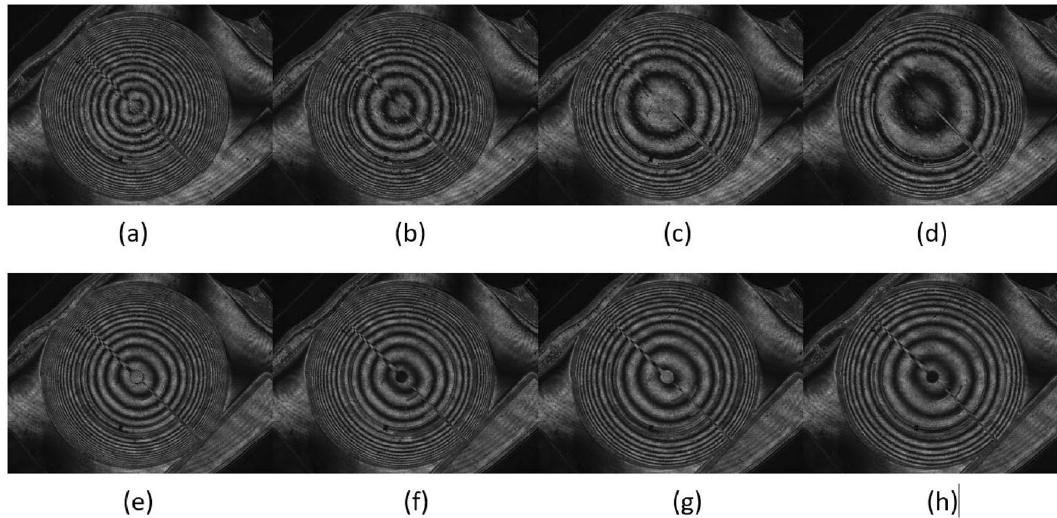
Figure 9. Interference patterns measured by placing the LC lens between crossed polarizers. Positive lens (V RMS values): ( a ) V 1 = 1.75 , V 2 = 0.5 , ( b ) V 1 = 1.5 , V 2 = 0.5 , ( c ) V 1 = 1.35 , V 2 = 0.5 , ( d ) V 1 = 1.25 , V 2 = 0.5 . Negative lens (V RMS values): ( e ) ( h ) V 1 = 1.65 , V 2 = 3.5 . The figure was generated using Spinview software with version no. 3.1 and link https://